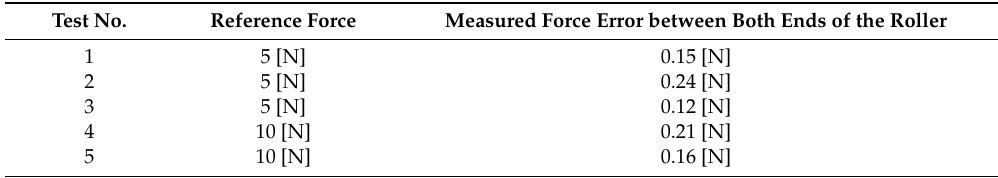
Figure 16. Test results of the improved automatic alignment control; reference force, 5 N; movement 1, 10 μ m; movement 2, 2 μ m. Table 3. Automatic alignment test results for random misalignment.